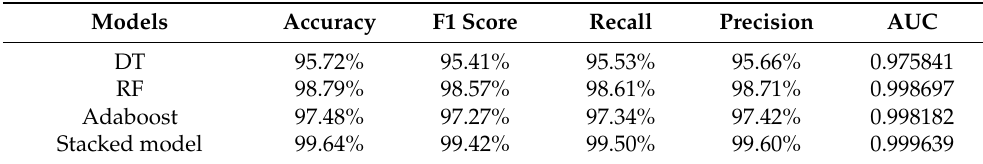
Table 5. Comparison of prediction performances between DT model, RF model, Adaboost model, and the stacked model,